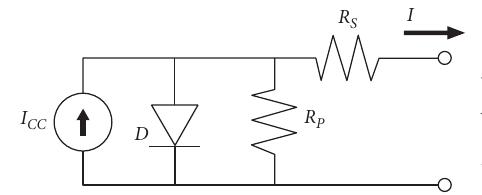
Figure 4: Equivalent circuit of PV